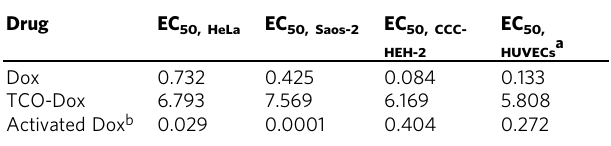
Table 1 Calculated EC 50 values for Dox, TCO-Dox and activated Dox against each cell line